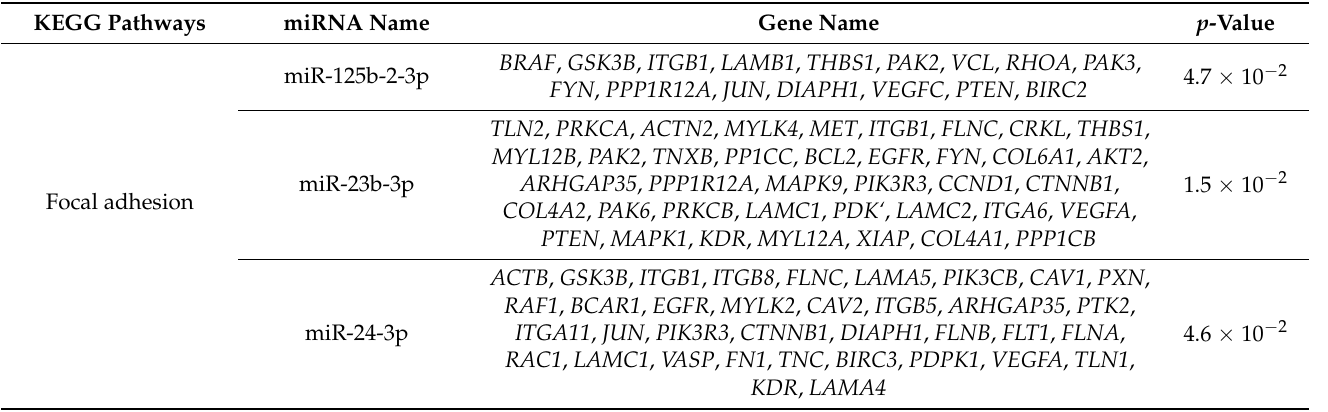
Table 4. ALF-related miRNAs comprising cellular community KEGG pathways and its predicted gene